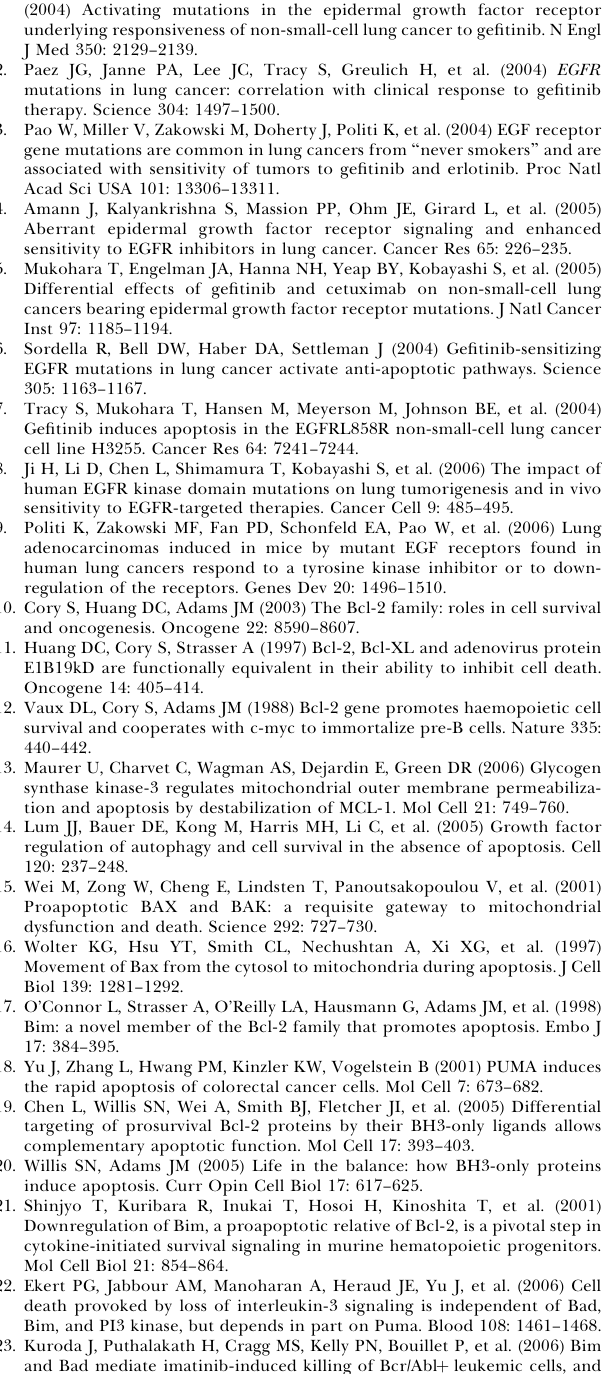
Cell lines were treated with either DMSO or different concentrations of erlotinib in 96-well plates for the indicated times. Caspase 3/7 activity per well was measured as described in the Methods. Values represent the mean 6 standard deviation of three independent experiments. Figure S2. MCL1 Elimination Is Not Required for Erlotinib-Induced Apoptosis in H3255 Cells Cells were treated with erlotinib (100 nM) alone or with erlotinib (100 nM) and the proteasome inhibitor MG132 (10 l M) for the indicated times. Cell lysates were analyzed by immunoblotting with the indicated